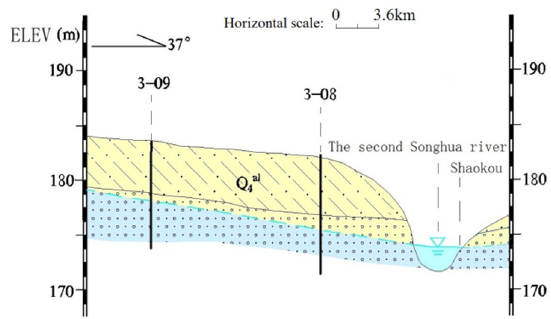
Figure 16. Location of hydrogeology cross sections.